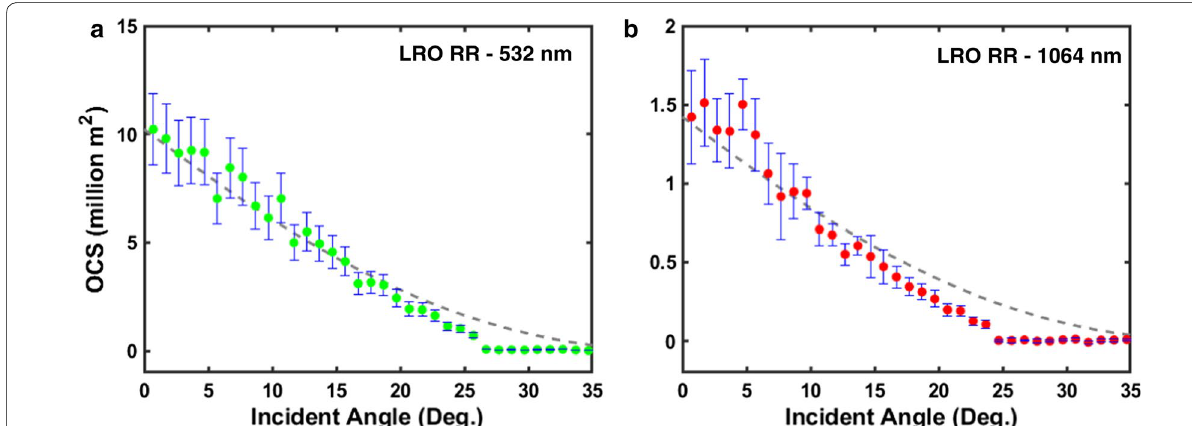
Fig. 4 New optical test results. Measurements of the peak optical cross‑sections (OCS) at 532 (left column) and 1064 nm (right column) of a RR flight spare of the LRO LRA. Five far‑field diffraction patterns were averaged for the entire range of the incidence angles tested; the error bars indicate one standard deviation. The gray line indicates the theoretical prediction based on the reduction of the cross‑sectional area (Minott 1974). The OCS measurements at each wavelength were calibrated against a 1.25‑in. silver